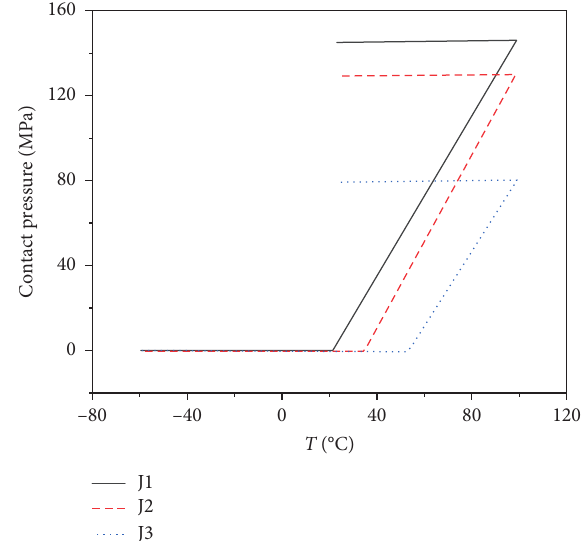
Figure 13: Longitudinal distributions of σ r in NiTiNb joints. Figure 14: Variations of σ r at the inner wall of different NiTiNb joints against T during heating and cooling for J1, J2, and